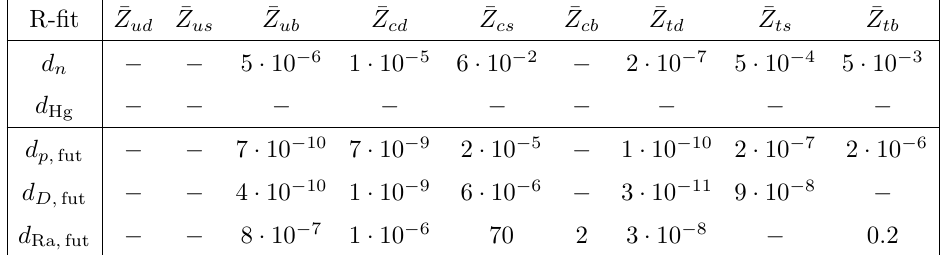
Z qq 0 for m LQ = 1 TeV. We varied the LQ